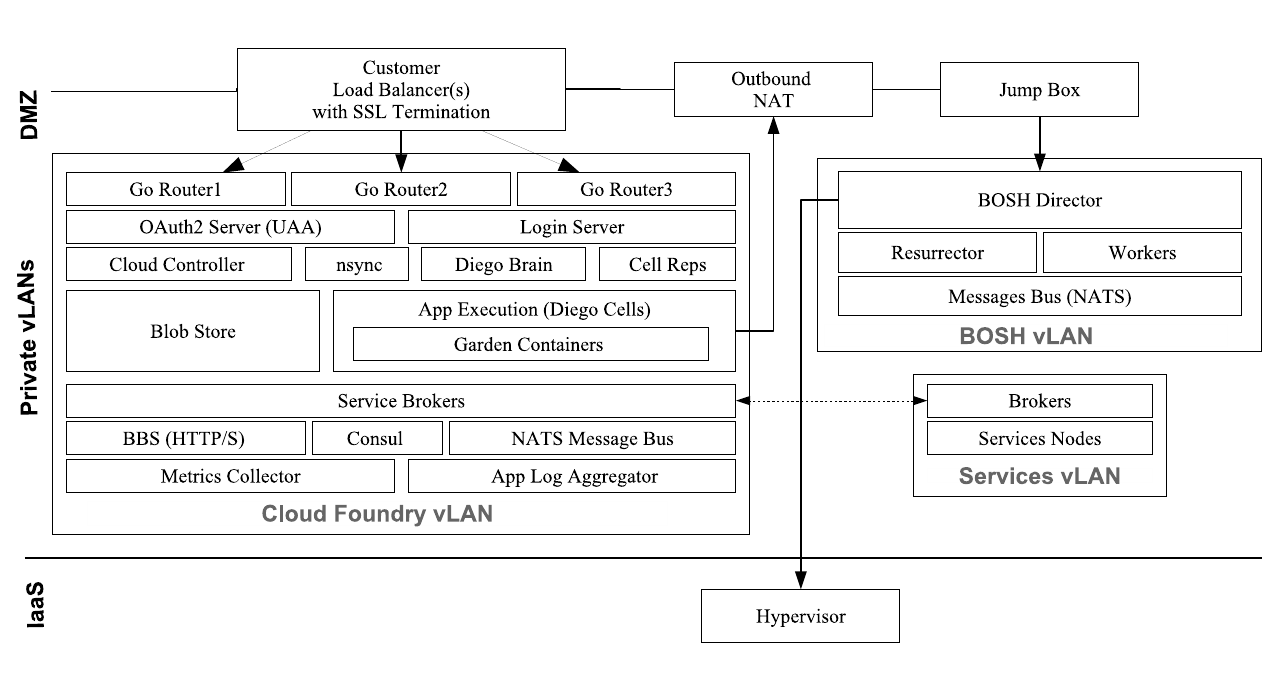
Figure 1. Security architecture of Cloud